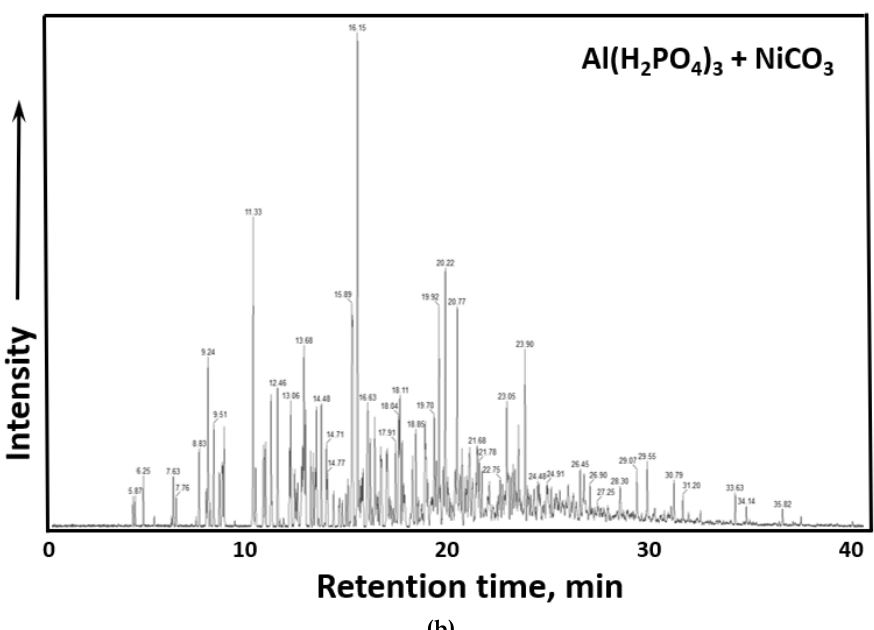
Figure 6. GC-MS results. ( a ) Spectra of benzene fraction of initial crude oil before thermolysis, ( b ) Spectra of benzene fraction of crude oil after thermolysis in the presence of Al(H 2 PO4) 3 + NiCO 3 .